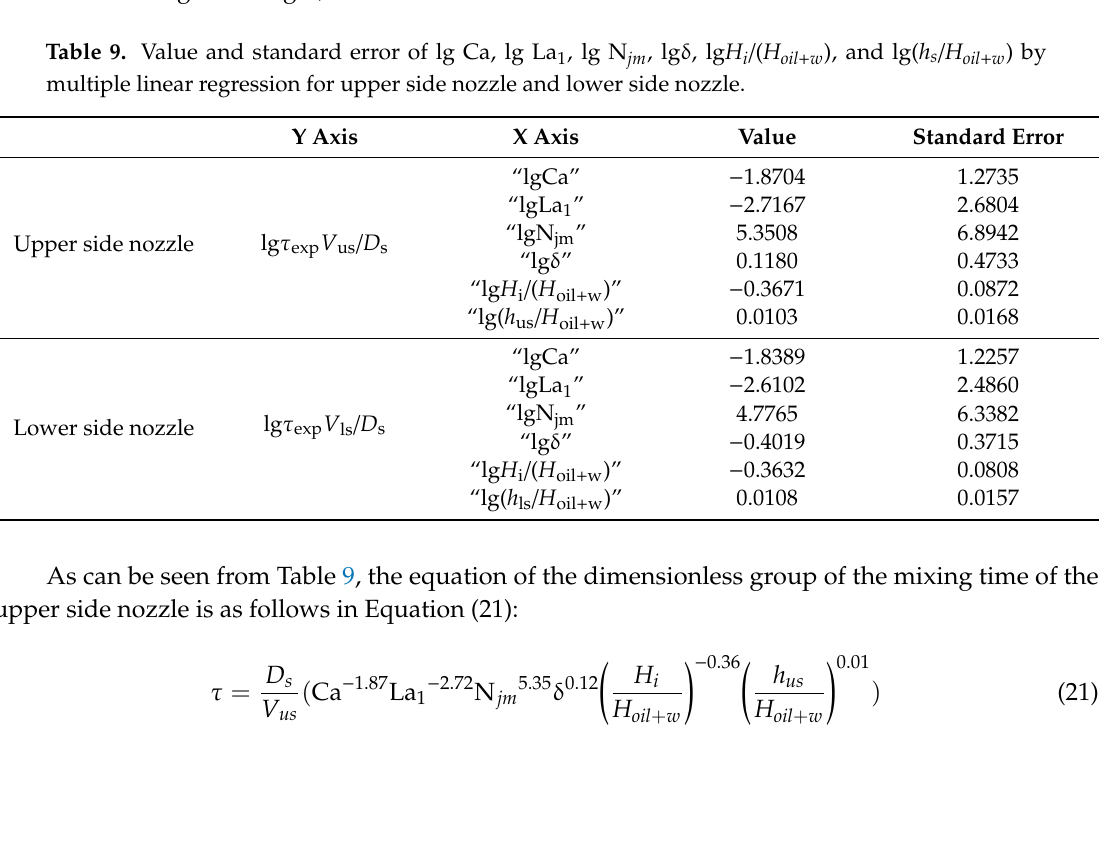
Figure 10. Comparison of experimental lg τ V s / D s with calculated ones for upper side nozzle ( a – c ) and lower side nozzle ( d – f ), respectively, using τ 1 , τ 2 , τ 3 .